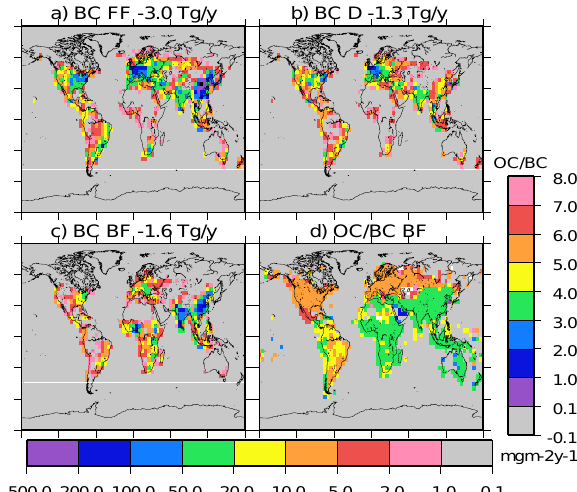
Fig. 1. Emission reductions for the three experiments (scale below): (a) fossil fuel BC, (b) Diesel BC, (c) Biofuel BC and (d) the ratio OC/BC that is reduced in the biofuel experiment (scale on